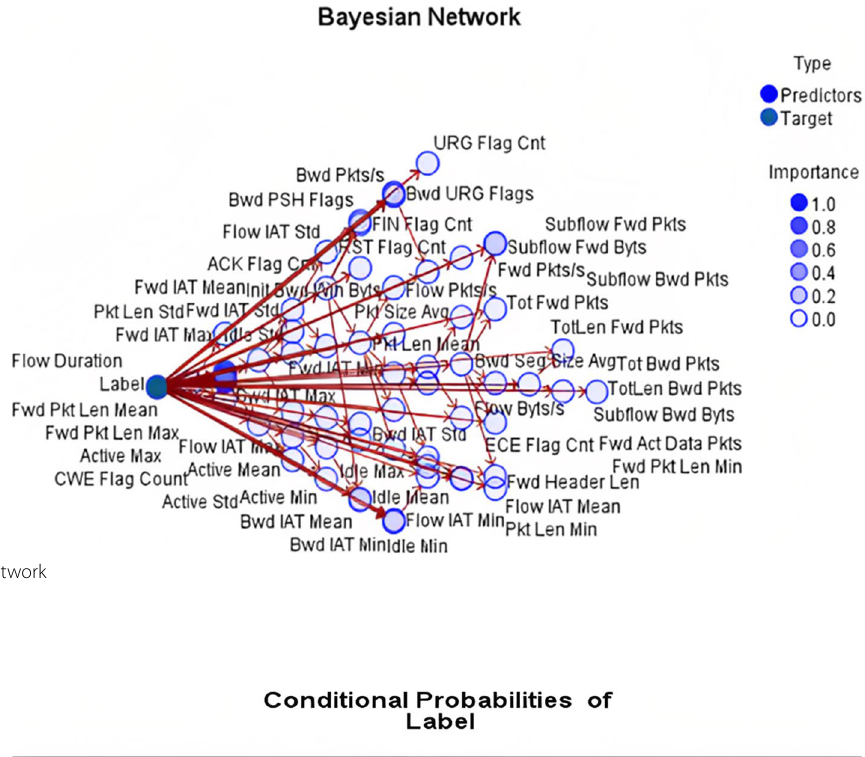
Fig. 3 Bayesian network